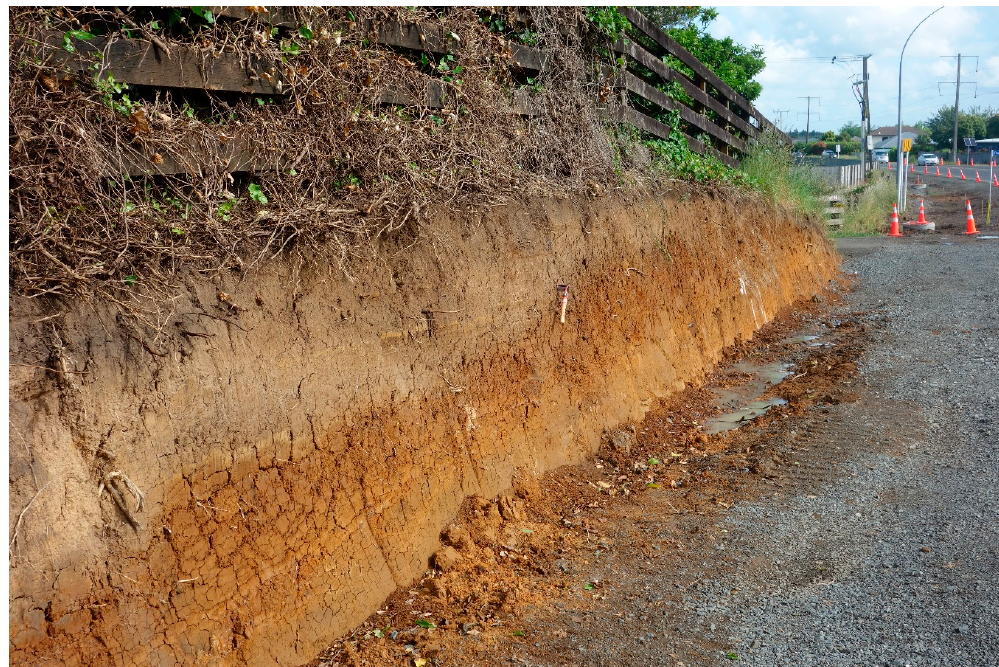
Figure 2. Exposure of Kainui silt loam on Gordonton Road practically opposite the intersection with Thomas Road (37 43’55” S, 175 17’15” E), northern Hamilton (Figure 1). The two-storeyed nature of the Kainui soil is striking, with the pale composite coverbed of late Quaternary tephras contrasting with the paleo-surface of the underlying dark reddish-brown clay-rich Hamilton Ash beds. The profile looks a lot like the ‘strong texture-contrast’ or ‘duplex’ soils that are common in Australia, e.g., [40,41] and elsewhere but it has quite different origins. The wavy to irregular boundary (marked by the small cutting tool c. 30 cm long) likely reflects tree-overturn hollows and mounds [42] (cf. [43]) (Figure 3). The thickness of the coverbed here—each part of which has been an ‘A’ horizon at the land surface at some time since c. 50 ka—ranges from a maximum of c. 0.7 m (foreground) to c. 0.3 m. Photo: D.J. Lowe.